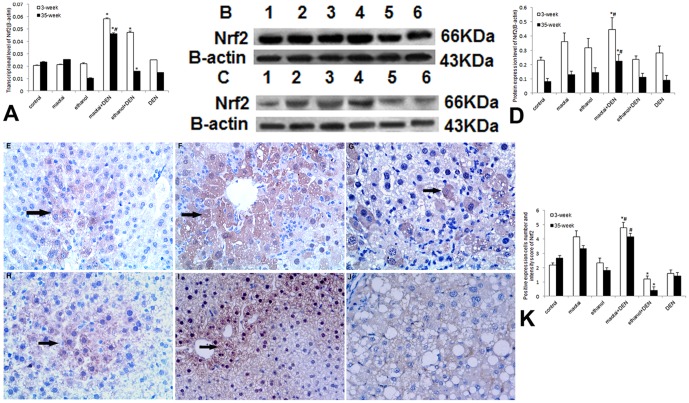
The expression level of Nrf2 in mice liver at 3-week and 35-week.A: Real-time RT-PCR analysis of Nrf2 gene expression. B–C: Western blot analysis of protein level of Nrf2 at 3-week and 35-week. lane 1.Control; lane 2.Maotai; lane 3.Ethanol; lane 4.Maotai+DEN; lane 5.Ethanol+DEN; lane 6.DEN; D: Quantification of Nrf2 level by western blot analysis. E–G, H–J: Light microscopy of Nrf2 expression through Immunohistochemistry in control group, Maotai+ DEN group and ethanol+ DEN group at 3-week and 35-week (400× magnification, allows indicate Nrf2 expression cytolymph and nucleus positive cells); K: Quantification of Nrf2 expression in Immunohistochemistry. Maotai + DEN treatment always enhanced the mRNA and protein expression of Nrf2 at both 3-week and 35-week (p<0.05), but ethanol + DEN treatment only transiently increased the mRNA level of Nrf2 at 3-week and the expression level of Nrf2 in this group showed no difference with that in control group at 35-week (p>0.05). *Significantly different in Maotai+ DEN group and ethanol+ DEN group from control group, #Significantly different in Maotai+ DEN group from ethanol+ DEN group, p<0.05.